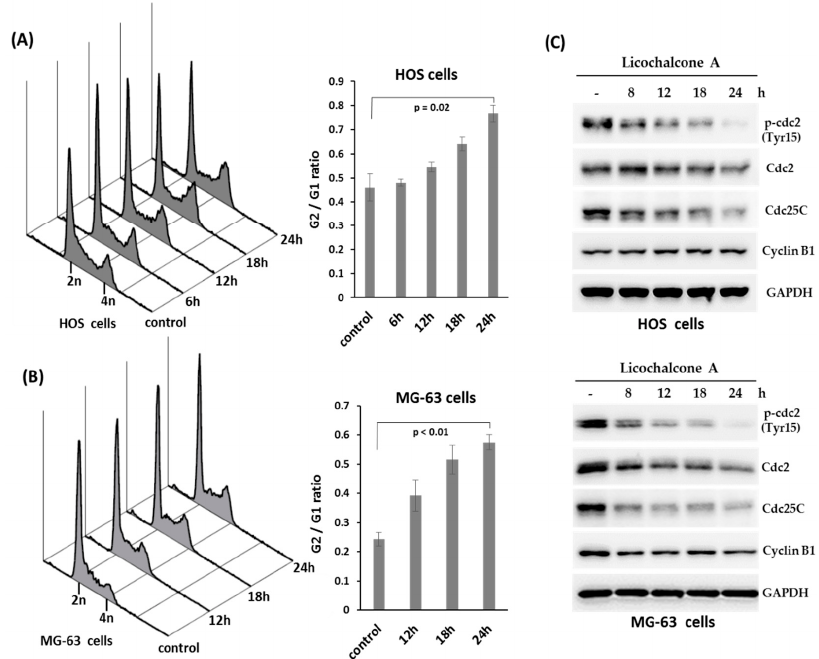
Figure 3. Licochalcone A induces G2/M phase arrest in osteosarcoma cell lines. HOS cells ( A ) or MG- 63 cells ( B ) were treated with Licochalcone A (30 μ M), and harvested in the indicated time points. The cells were stained with propidium iodide and analyzed by flow cytometer. 2n corresponds to G1 phase cells and 4n corresponds to the G2/M phase cells. The ration of G2/M to G1 phase cells were showed in right panel. Experiments were conducted with three biological replicates per condition, and the values represent the mean ± SD. ( C ) Licochalcone A decreases the expression of p-cdc2, cdc2, and cdc25c in osteosarcoma cell lines. HOS cells or MG-63 cells were treated with Licochalcone A (30 μ M), and harvested in the indicated time points. The treated cells were analyzed by Western blotting using the indicated antibodies.